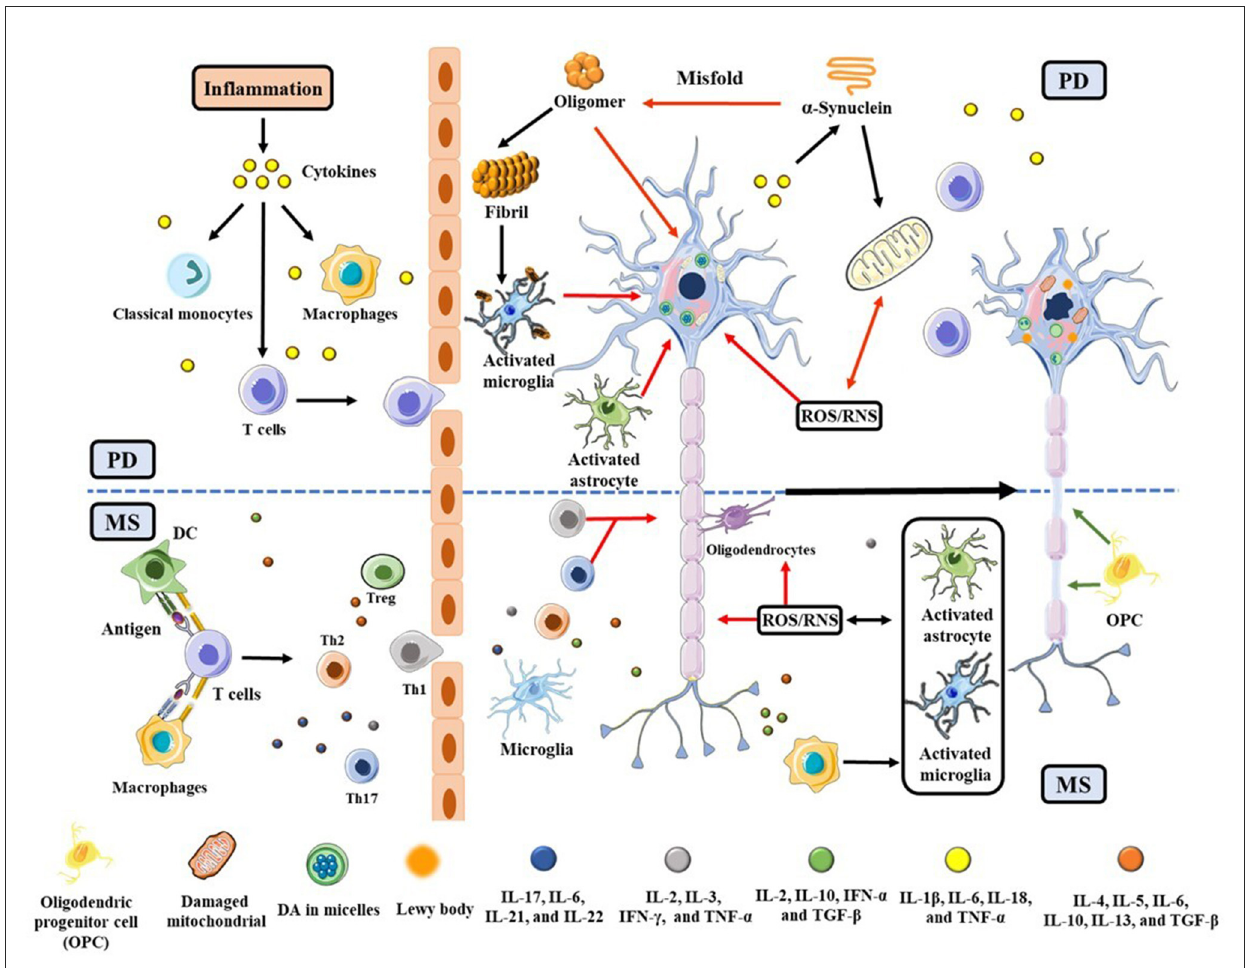
FIGURE1 Schematic illustration of PD and MS pathogeneses triggered by neuroinflammation and OS, with an emphasis placed on their commonalities. The red and green arrows represent the neuronal lesions and repairs, respectively. The upper half of the scheme (above the dashed blue line) is related to PD and the lower half is specific to MS.